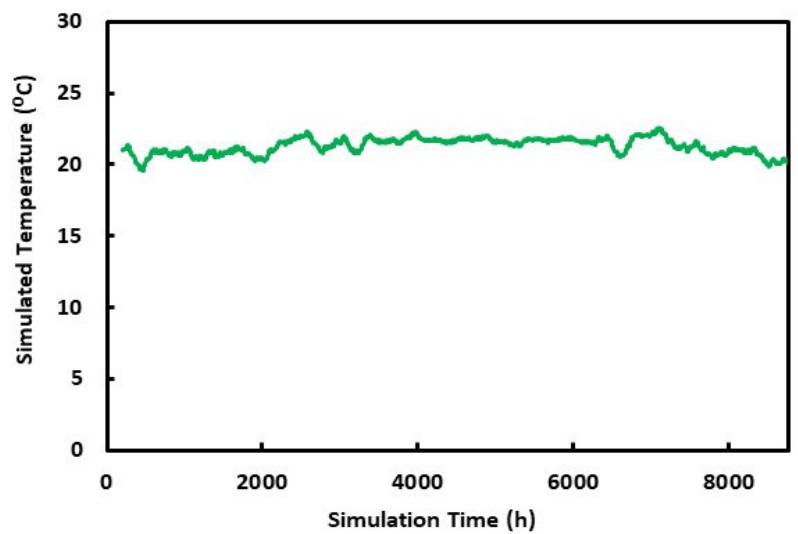
Figure 7. Average house temperatures during one-year period in the city of Vancouver.